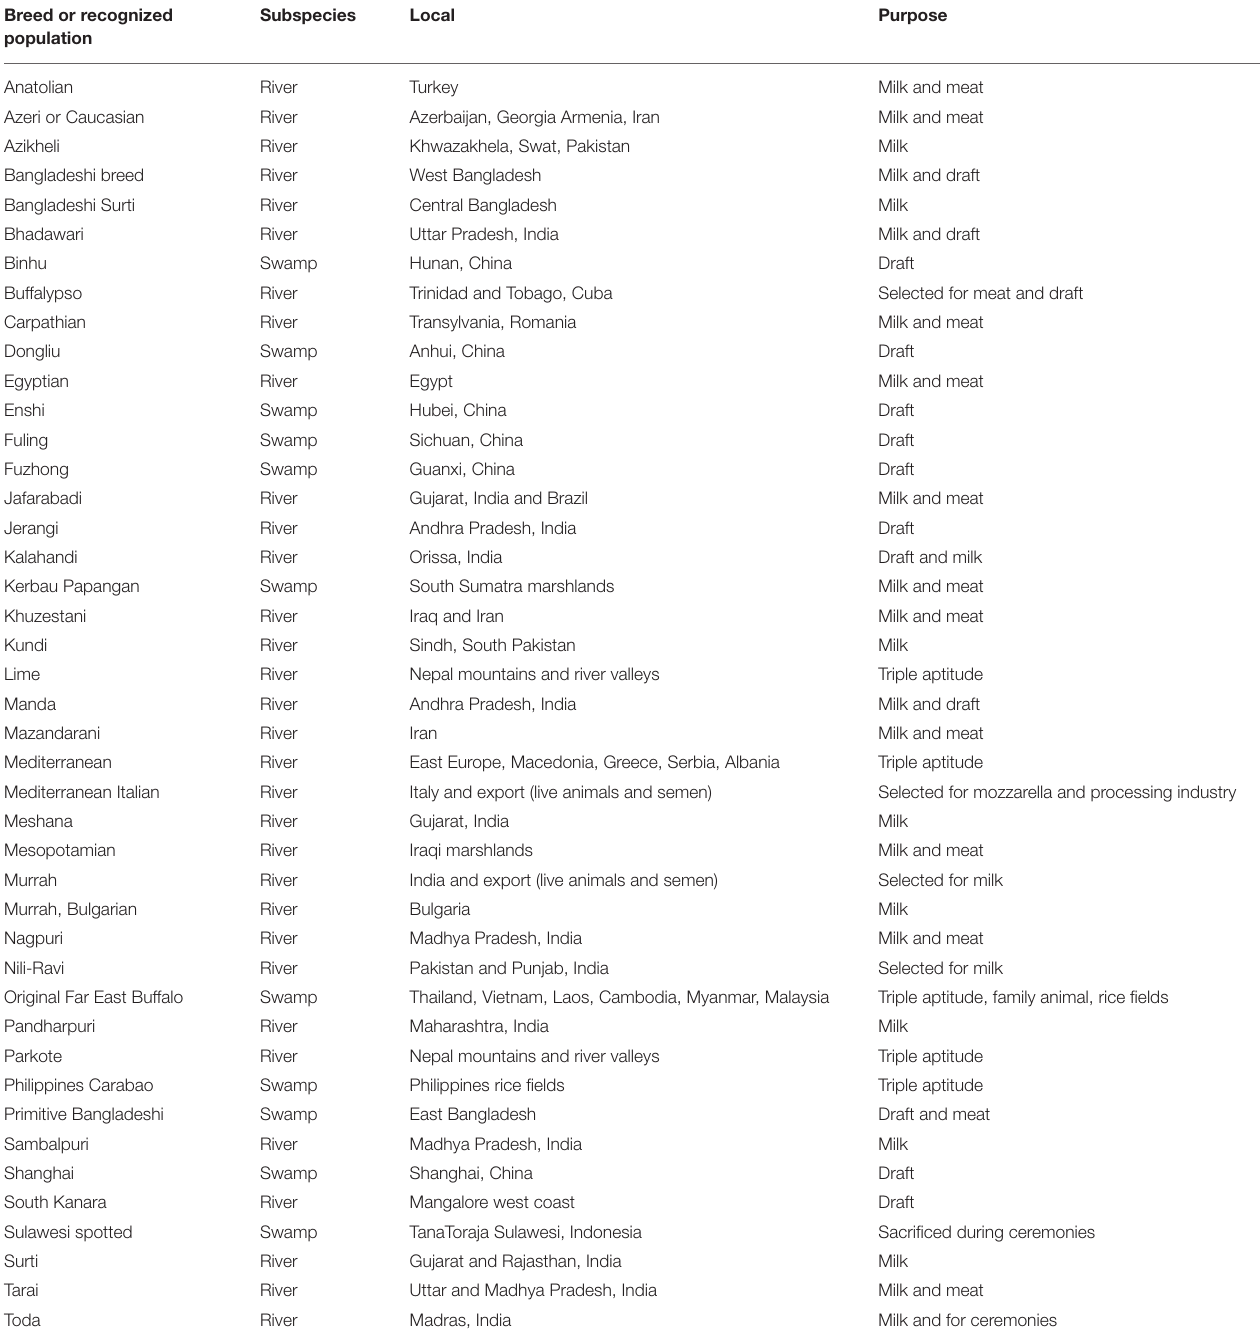
TABLE 1 | Breeds or recognized population of water buffalo worldwide. Breed or recognized